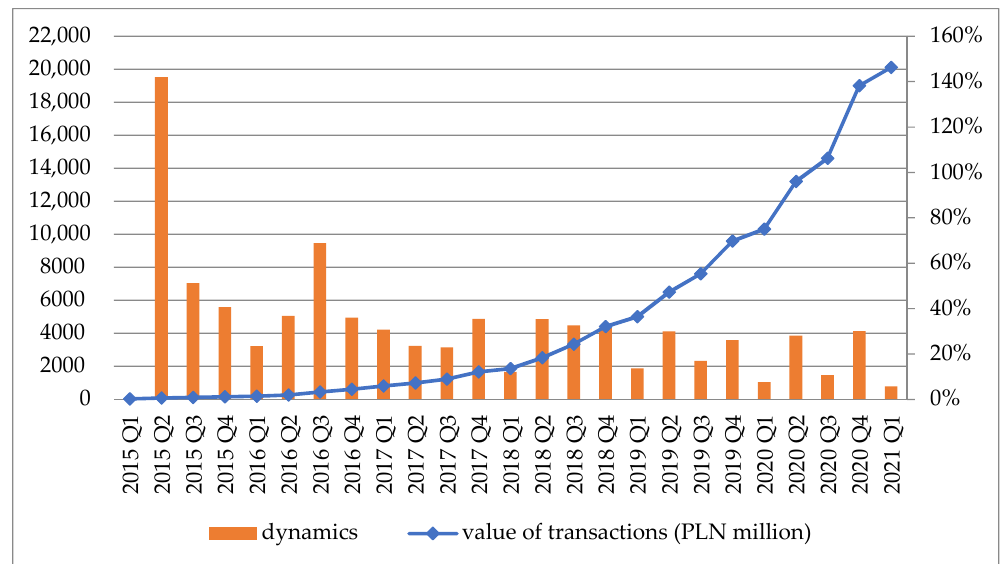
Figure 2. Value of BLIK transactions and its dynamics. Source: own elaboration based on NBP Reports (2015–2021): Informacja o rozliczeniach pieniężnych i rozrachunkach międzybankowych w latach 2015 2016 2017 2018 2019 2020 and 2021, https://www.nbp.pl/home.aspx?f=/systemplatniczy/publikacje/rozrachunki.html, accessed on 10 July 2021.